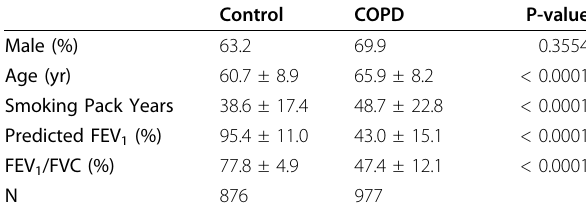
Table 2 Characteristics of Controls and COPD